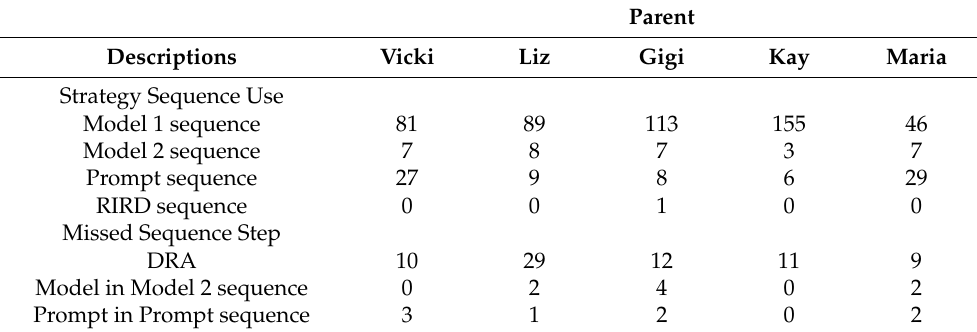
Table 6. Parent Strategy Sequence Frequency of Use and Missed